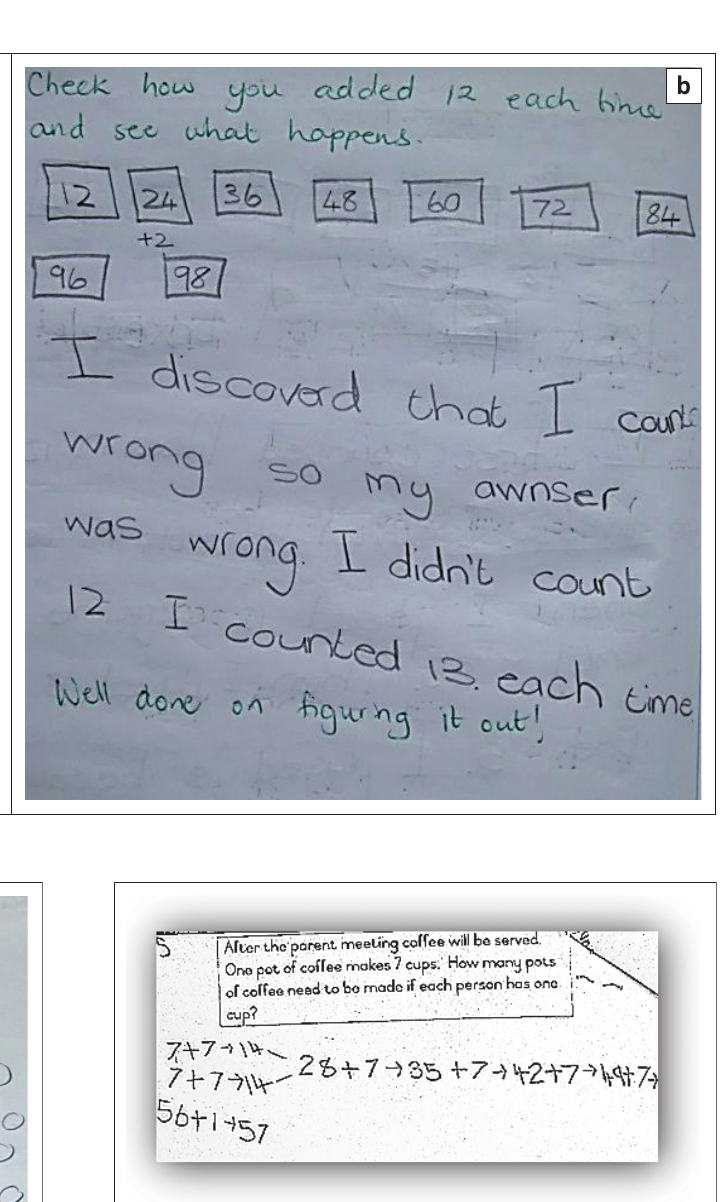
FIGURE 12: Bevan